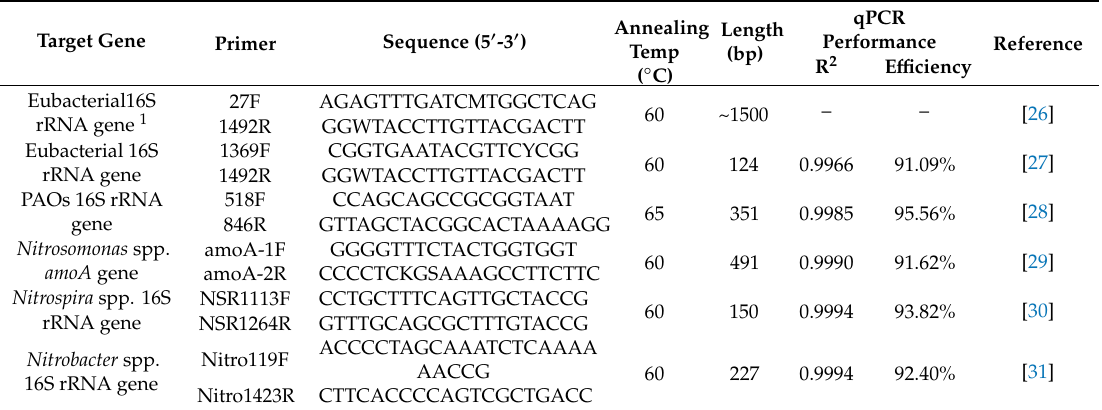
Table 3. Primers Used in This Study and qPCR